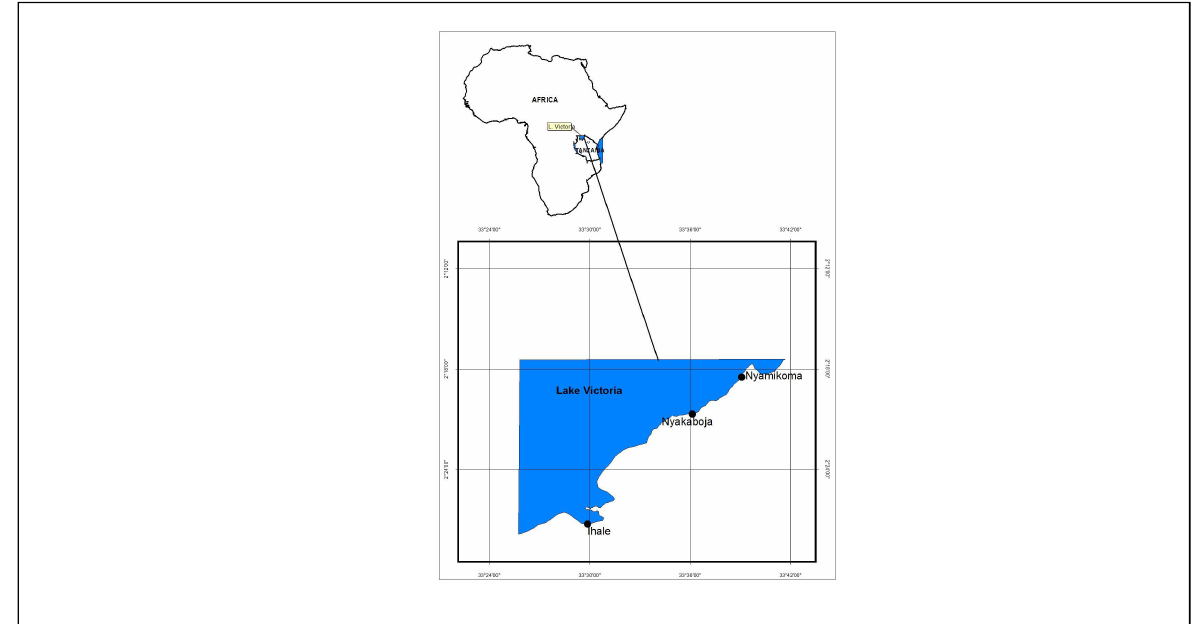
Figure 1: A Map showing the three landing sites (Nyamikoma, Nyakaboja and Ihale) at Magu-